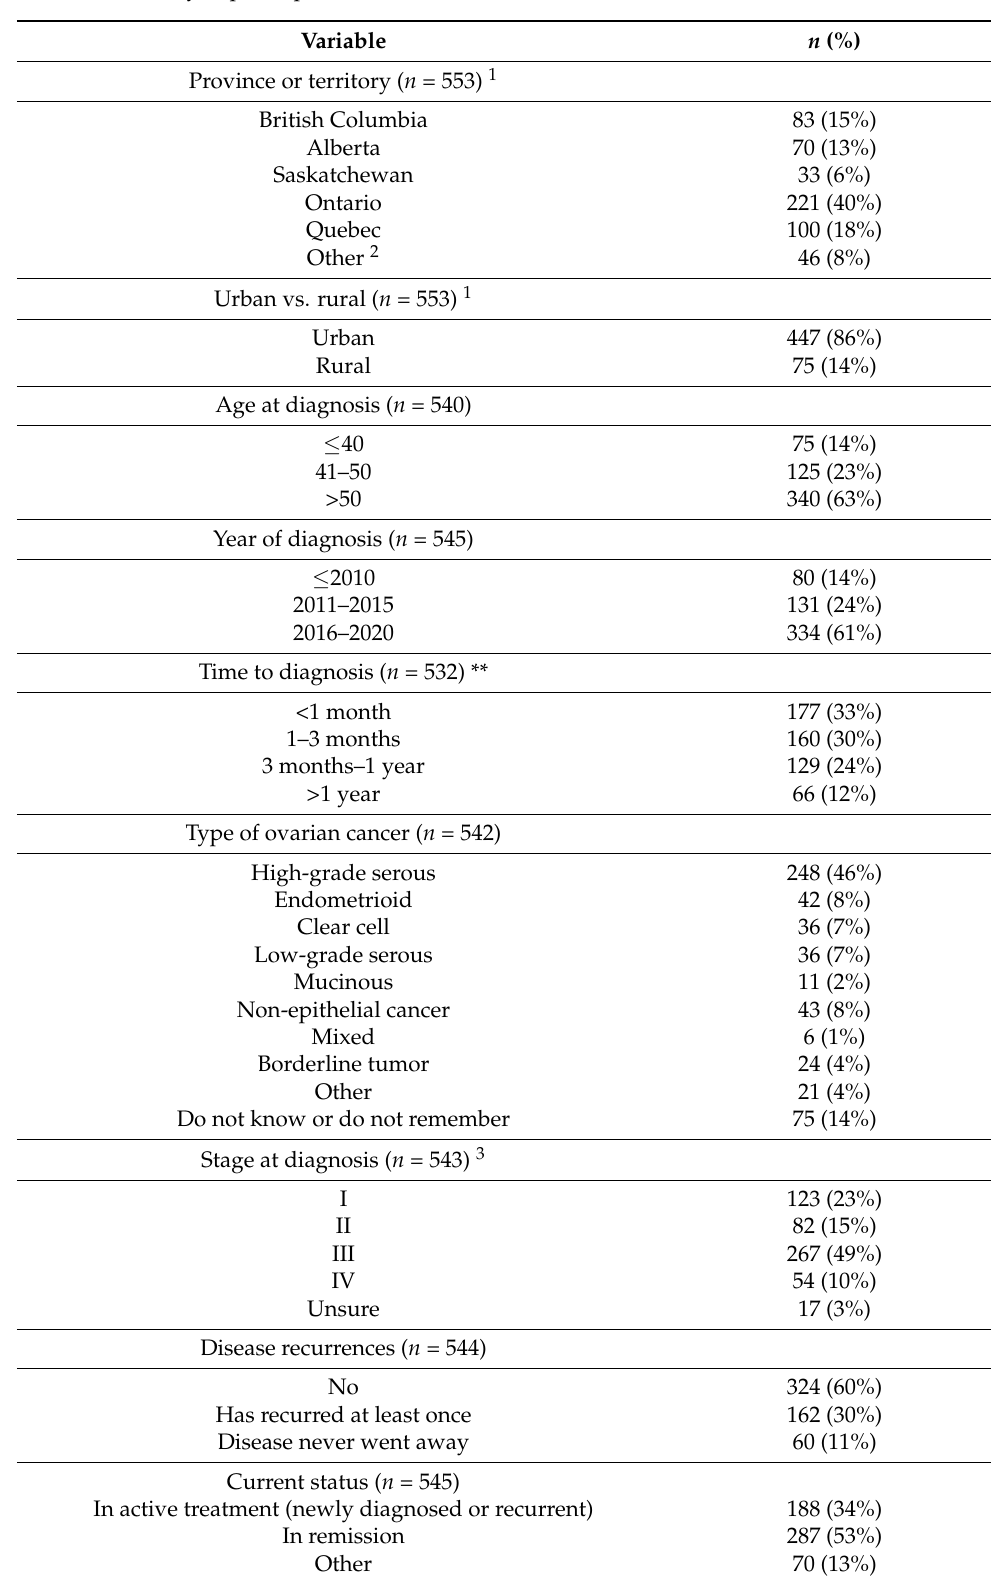
Table 1. Summary of participant characteristics